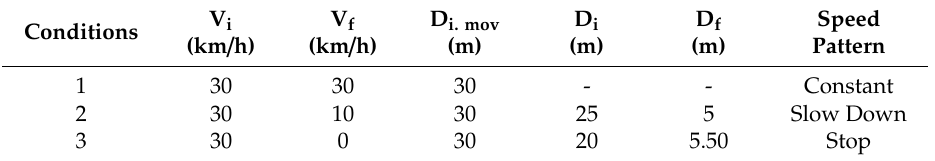
Table 2. Characteristics of vehicle movement in the di ff erent conditions presented in the